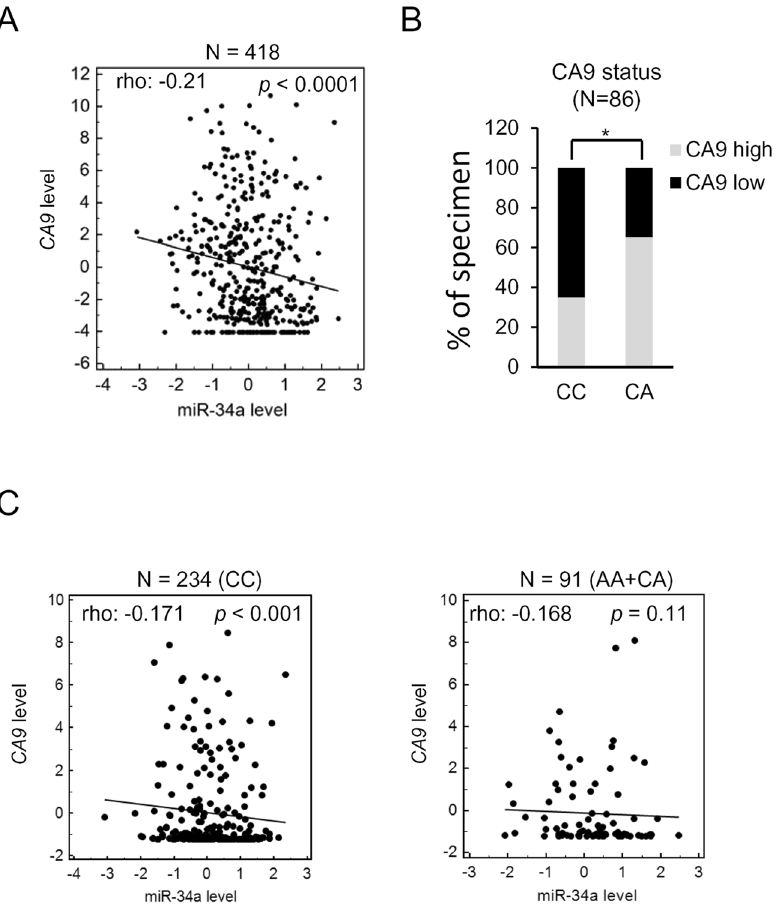
Figure 5. Association of rs1048638 with CA9 expression in hepatocellular carcinoma (HCC) patients. ( A ) RNA expression scatter diagrams of CA9 mRNA versus miR-34a. Black dots represent expression levels of both genes from specimens in TCGA HCC dataset; the regression line is shown on the plot. ( B ) Correlations between CA9 mRNA levels and rs1048638 genotypes in 86 HCC specimens. * p < 0.05 by Chi-squared test. ( C ) CA9 mRNA versus miR-34a expression scatter diagrams of specimens from rs1048638-CC or rs1048638-AA/CA cohorts. Statistical significance of ( A ) and ( C ) was assayed by Spearman’s rank correlation test. p values are labeled in the